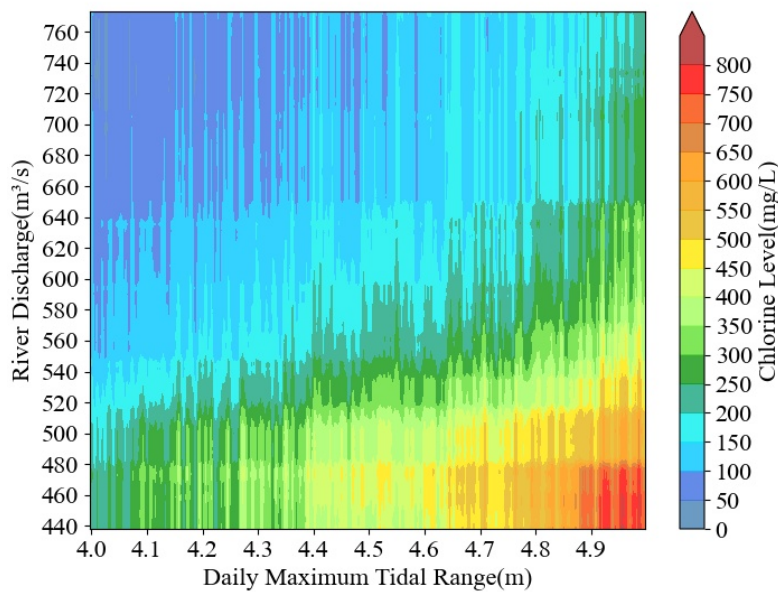
Figure 7. River discharge—tidal range—chlorine level relationship.